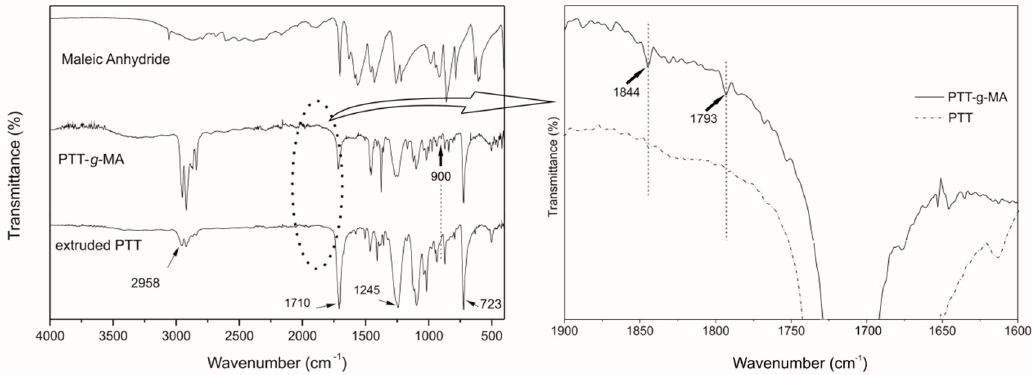
Figure 2. FTIR spectra of maleic anhydride, PTT- g -MA, and extruded PTT (left) and zoom at region between 1900–1600 cm − 1 (right).